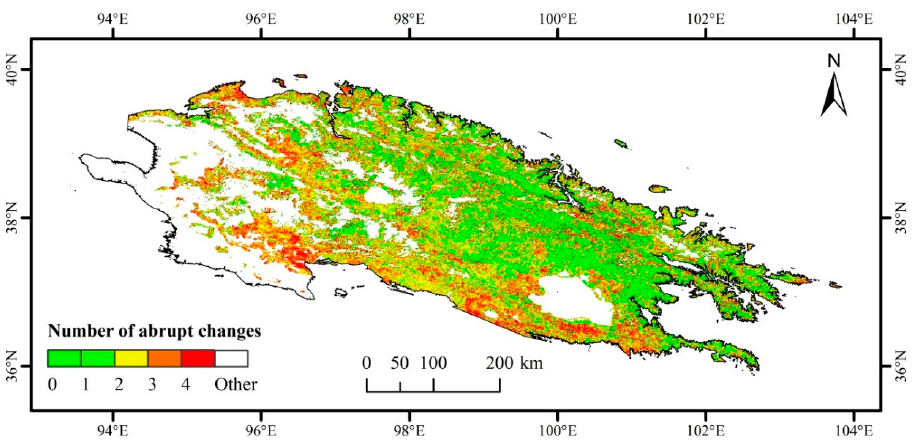
Figure 4. Spatial distribution of the estimated number of abrupt change points in the trend component in the Qilian Mountains in the period of 2000–2017. “Other” means no vegetation and managed vegetation areas.